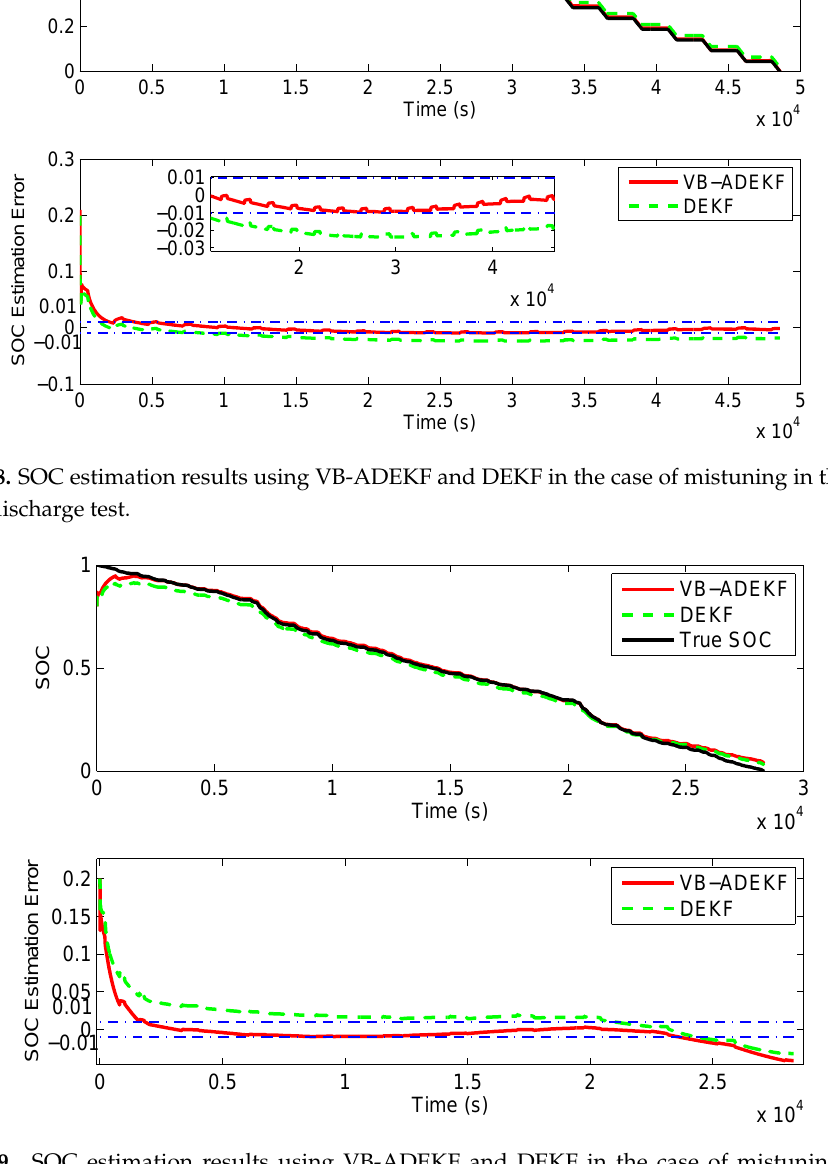
Figure 19. SOC estimation results using VB-ADEKF and DEKF in the case of mistuning in the UDDS